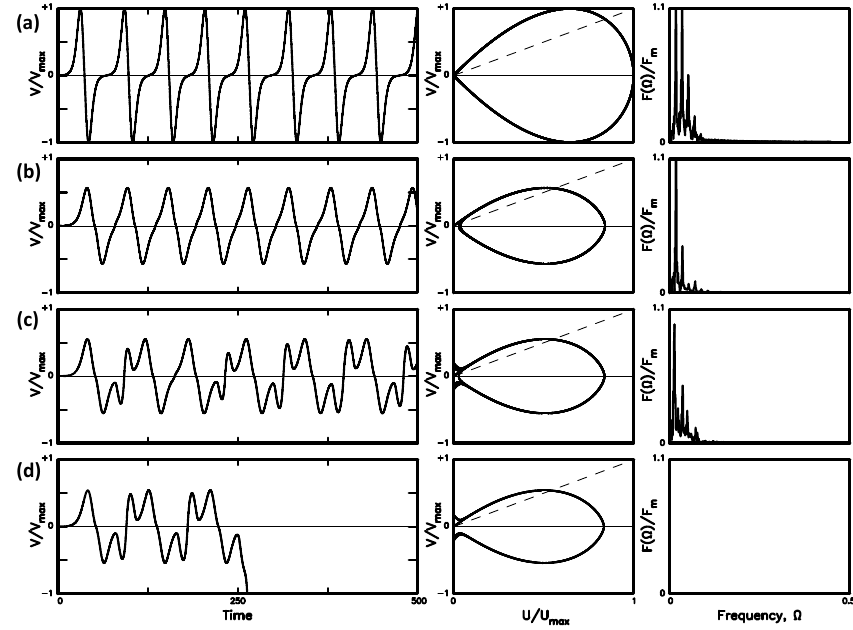
Figure 12. The time variation in V/V max , the phase portrait of V/V max versus U/U max , and the power spectrum for four values of η : (a) for η = 0 . 14; (b) for η = 0 . 36; (c) for η = 0 . 37; and (d) for η = 0 . 38 when U c = 0 . 9 for the TP law of F(U) = exp ( − U/U c ) .